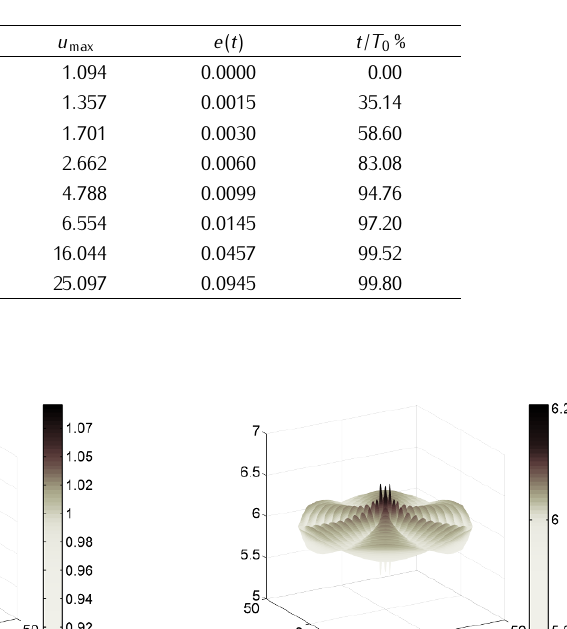
Table 2. Metastability of the wave from Example 3.1.